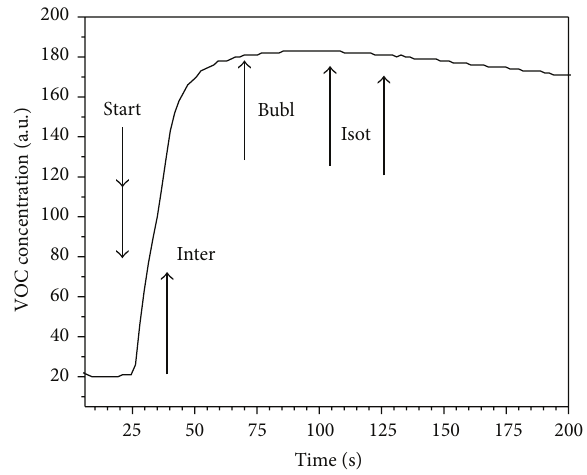
Figure 1: Typical dependence of ethanol concentration in the con- tainer as a function of time (measured by tin oxide sensor). Area marked as “Isot” corresponds to isotropisation, area “Bubl” corresponds to bubbles formation, and area “Inter” corresponds to changes in interference pattern. Injection of ethanol occurred at ca. 20th s (this point is marked as